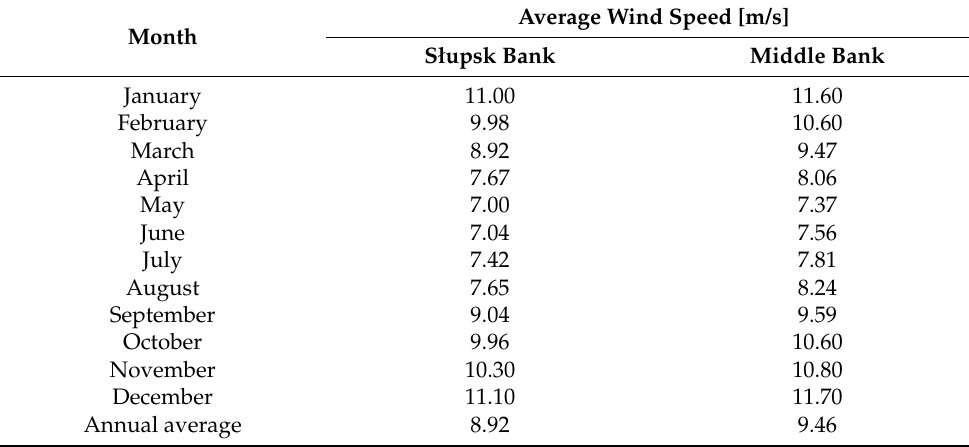
Table 4. Average wind speed at the height of 110